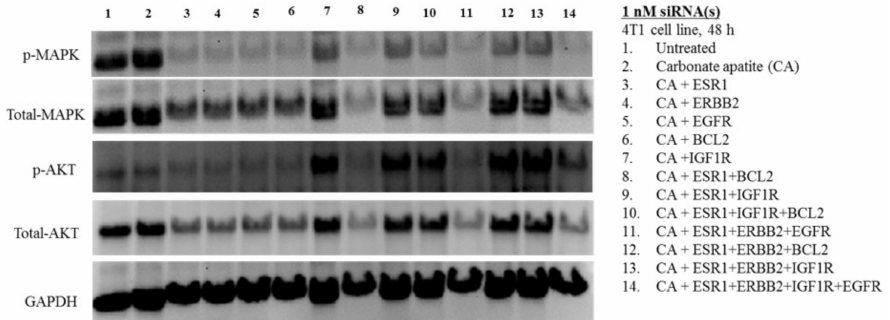
Figure 7. Effects of intracellular delivery of various CA ‐ siRNA complexes on expression and activation of AKT and MAPK proteins in 4T1 cell line. Preparation of the CA ‐ siRNA(s) complexes involved introduction of ESR1, ERBB2, IGF1R, EGFR and BCL2 siRNAs individually or in combination with 3.5 mM of CaCl 2 to 1 mL of bicarbonate ‐ buffered DMEM (pH 7.4). The mixture was allowed incubation at 37 °C for 30 min before the addition of 10% FBS. The cells were incubated for a consecutive period of 48 h with the prepared complexes, prior to cell lysis for protein extraction and Western blot analysis. Proteins were loaded on SDS ‐ PAGE and transferred onto nitrocellulose membrane for detection of p ‐ MAPK, p ‐ AKT, total MAPK, total AKT and GAPDH (housekeeping protein) expressions.